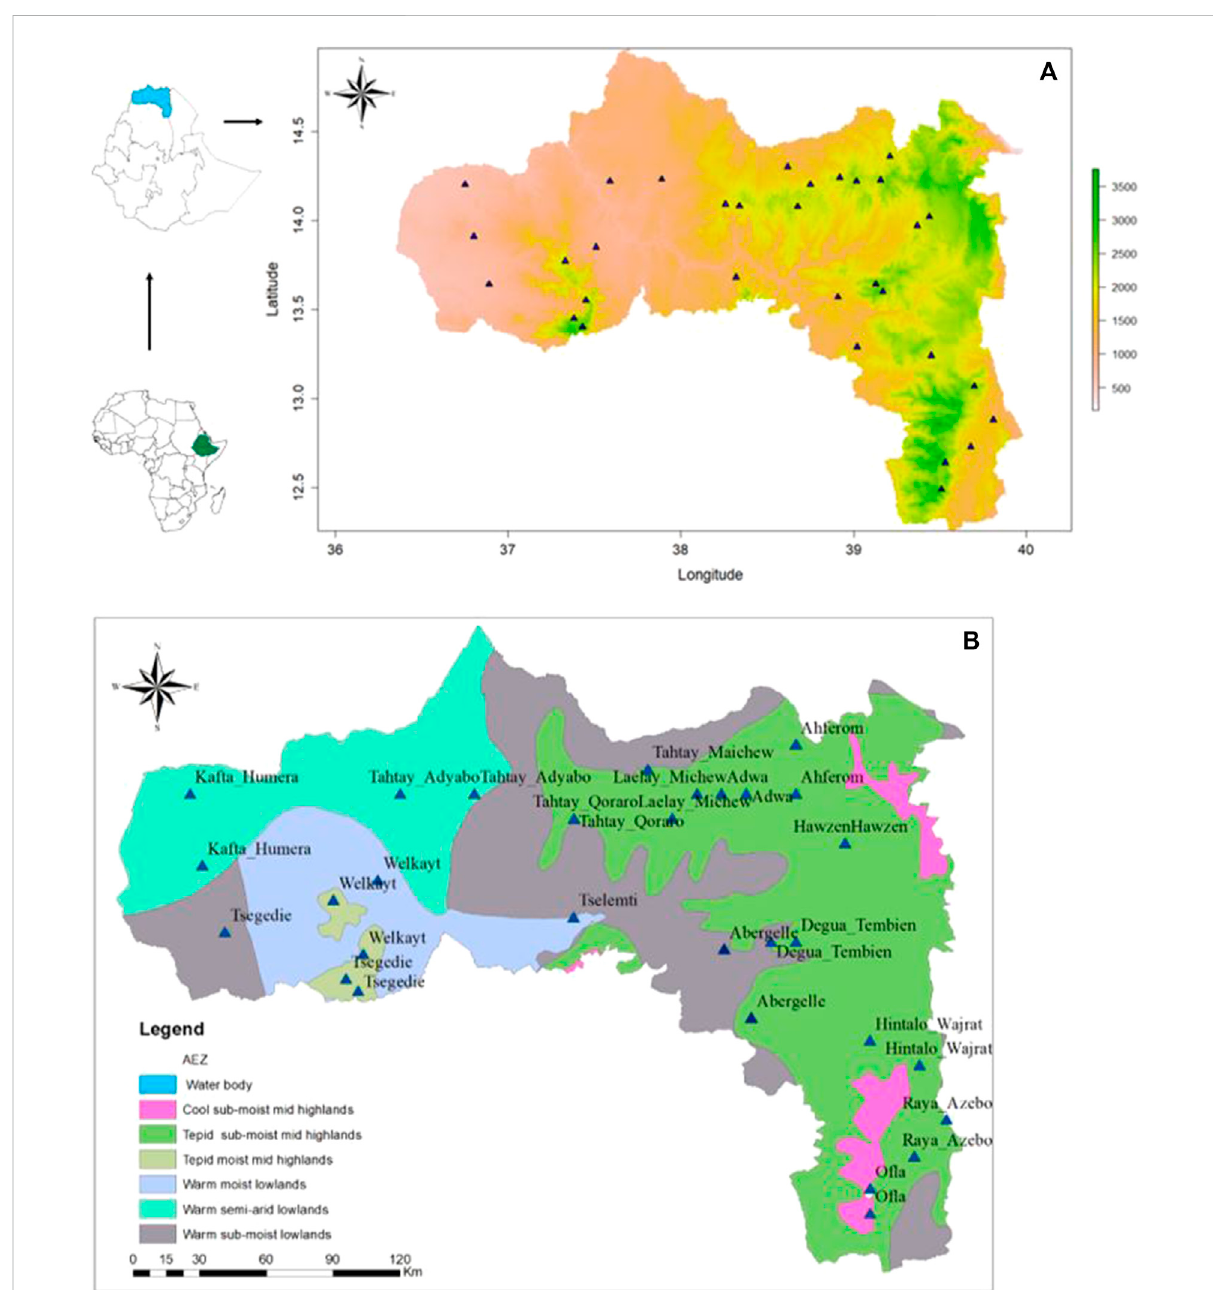
FIGURE 1 Maps showing the sampling sites of indigenous chickens from the Tigray region (A) based on bio-elevation, and (B) based on major agro- ecological zones; source (MOA,